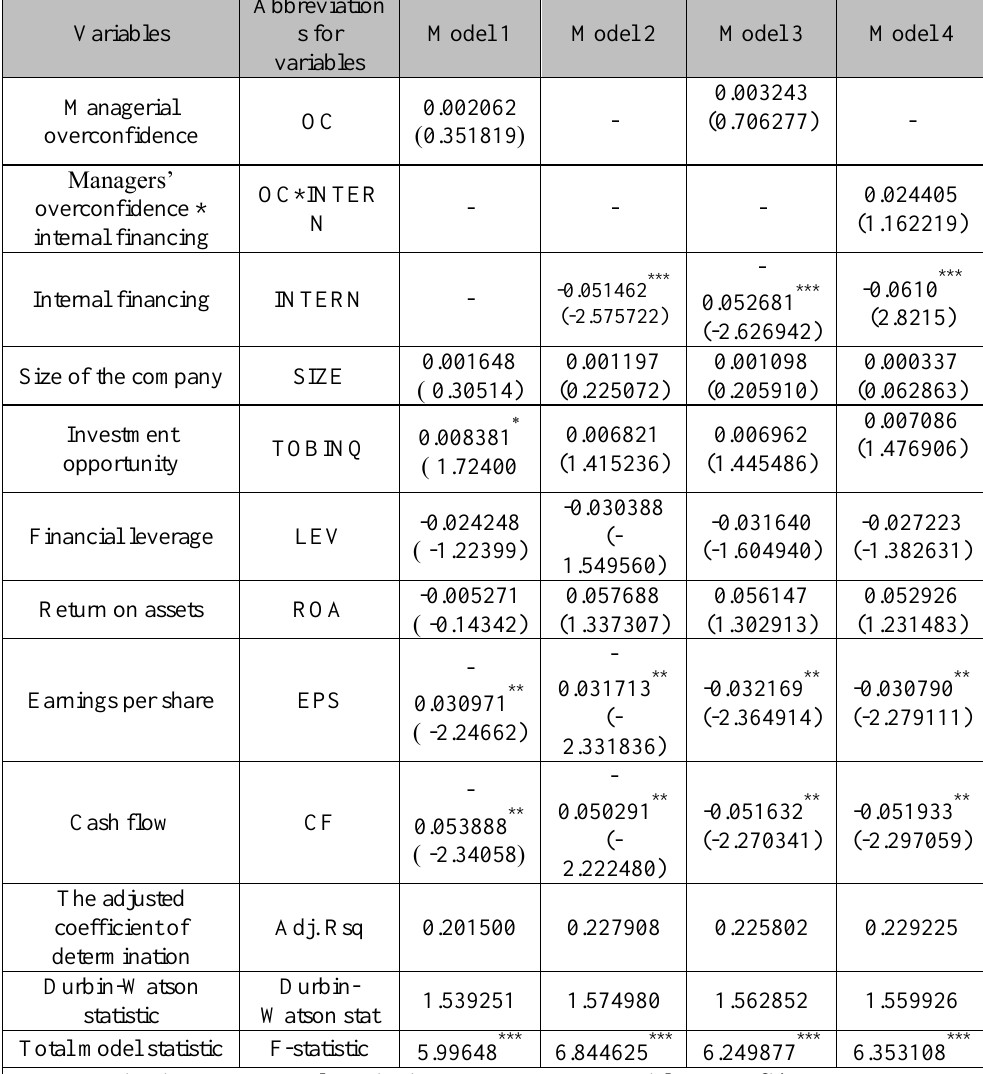
Table 9. Results of typical regression test - Dependent variable of